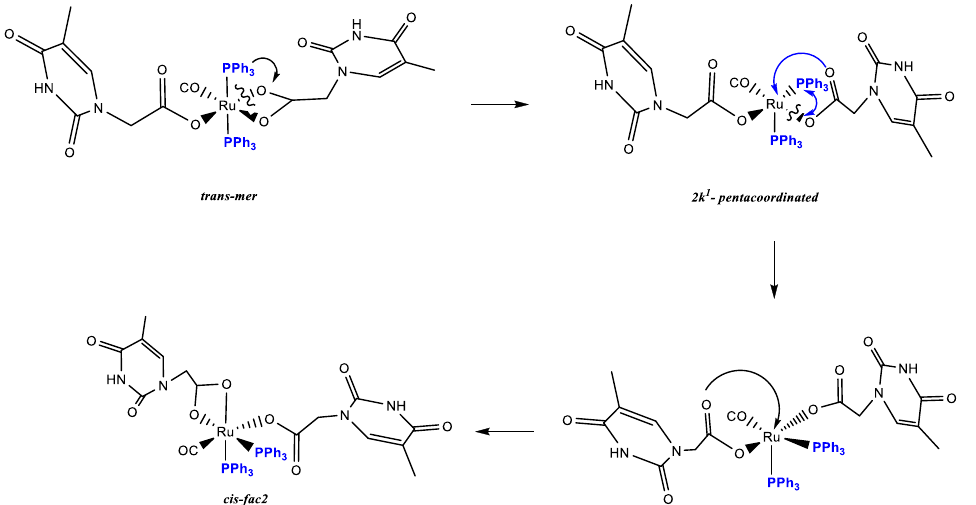
Scheme 1. The fluxional interconversion between trans -, mer- 2 isomer and the related cis,fac- form envisages the forma- tion of a transient penta-coordinated species, bearing double κ 1 -THAc coordination mode which affords the complete transformation to the cis- 2